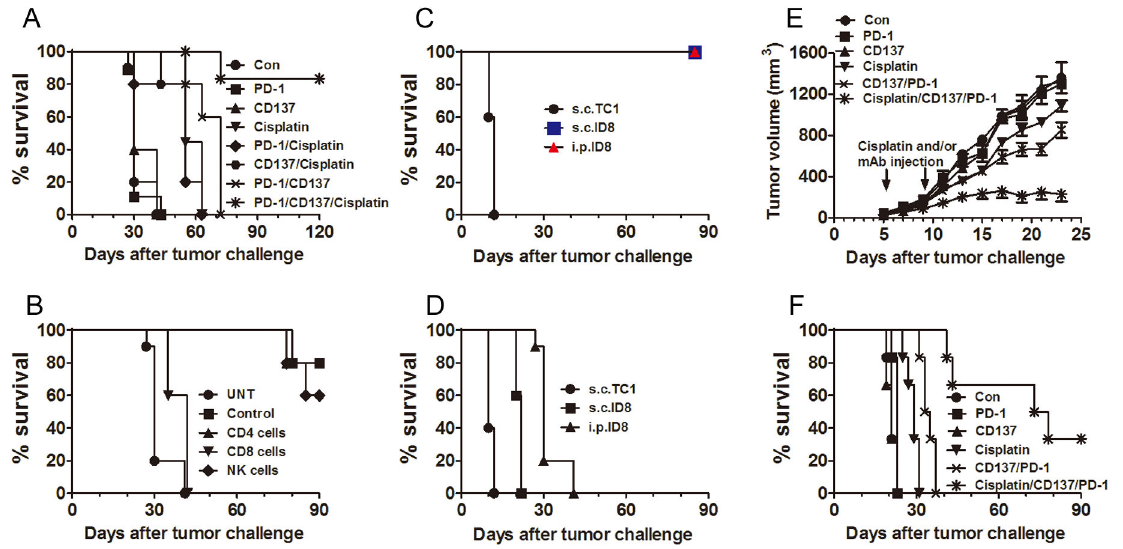
Figure 6. Combining anti-PD-1/CD137 mAb with cisplatin induced complete remission of established ID8 cancer with long- lasting systemic tumor-specific immunity. Mice (10/group) transplanted i.p. with 3 x 10 6 ID8 cells 10 days earlier were injected i.p. with two doses of control, anti-PD-1, anti-CD137 or anti-PD-1/CD137 mAb (0.5 mg per dose per mouse) at 4 days interval with or without coadministration of cisplatin (10mg/kg) at the first treatment and their survival was evaluated (A). Mice (10/group) treated with combined anti-PD-1/CD137/cisplatin were depleted of lymphocyte subsets by injection of anti-CD4 (0.2 mg/mouse), anti-CD8 (0.2 mg/mouse), anti-NK1.1 (0.1 mg/mouse) or control mAb (0.2 mg/mouse) 48 and 72 hours prior to the first treatment and every 3-4 days thereafter for the duration of the experiments. Untreated tumor-bearing mice were as negative controls (UNT group). The survival of mice was recorded (B). Fifteen long-term surviving mice (120 days after original transplantation of ID8 cells) pooled from 2 experiments were challenged (5 mice/group) with ID8 cells given i.p. or s.c. or with TC1 cells transplanted s.c. (C); naive mice were transplanted with tumor cells as controls (D) and their survival was recorded. Mice (6/group) with established TC1 tumors of 4-5 mm mean diameter were injected i.p. with two doses of control, anti-PD-1, anti-CD137 or anti-PD-1/CD137 mAb (0.5 mg per dose per mouse) at 4 days interval with or without coadministraation of cisplatin (10 mg/kg) at the first treatment; tumor growth was measured (E) and survival was recorded (F). Data are representative of 2 experiments for Figure